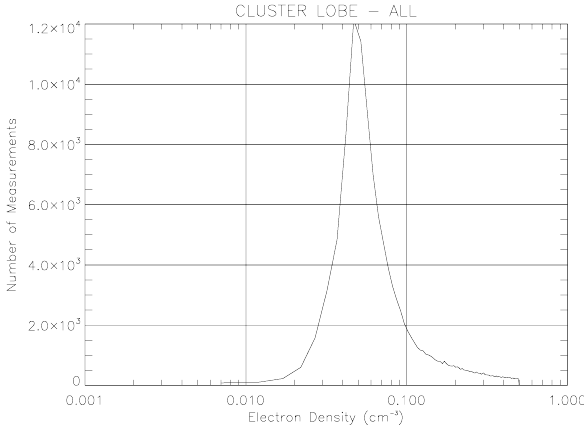
Fig. 3. This figure shows the distribution of the number of mea- surements as a function of electron density. The plot displays the resulting histogram after dividing the full density range into 100 bins. As is seen from the sharp maximum, the most likely density encountered here is 0.047cm − 3 .